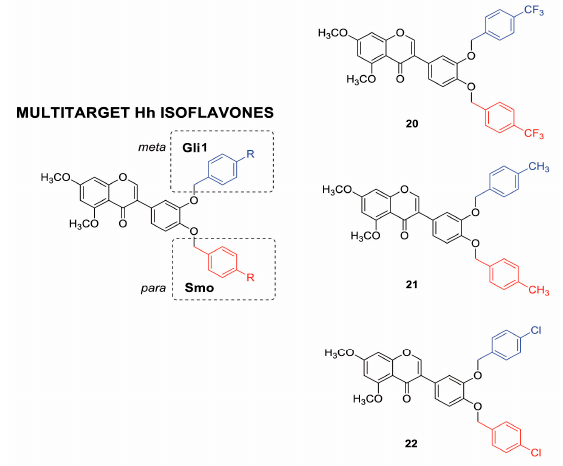
Figure 1. Chemical structure of isoflavones 20–22 . GlaB-ring B derivatives were designed as multitarget Hh inhibitors and synthesized via deoxybenzoin route. O-substitution at meta position of ring B (blue) is preferred to interact with Gli, whereas, O-substitution at para position (red) is preferred for the interaction with